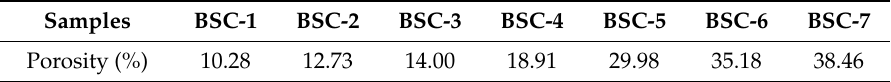
Figure 1. Image processing system: the capturing images and the threshold B / W: ( a ) BSC-1, ( b ) BSC-1 threshold B / W, ( c ) BSC-7, and ( d ) BSC-7 threshold B / W. Table 1. Porosity of each warp-knitted BSC was calculated by the image processing